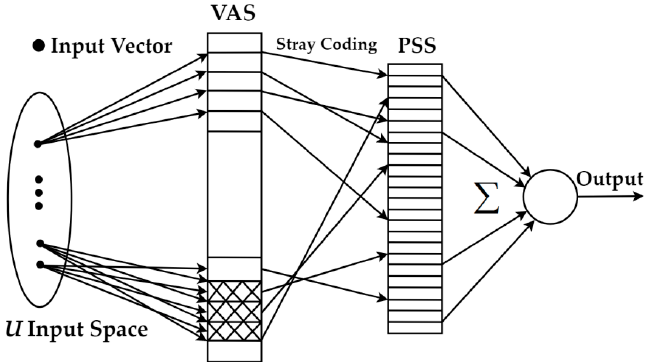
Figure 8. A cerebellar model articulation controller (CMAC) control structure diagram. VAS: virtual associative space; PSS: physical storage space.